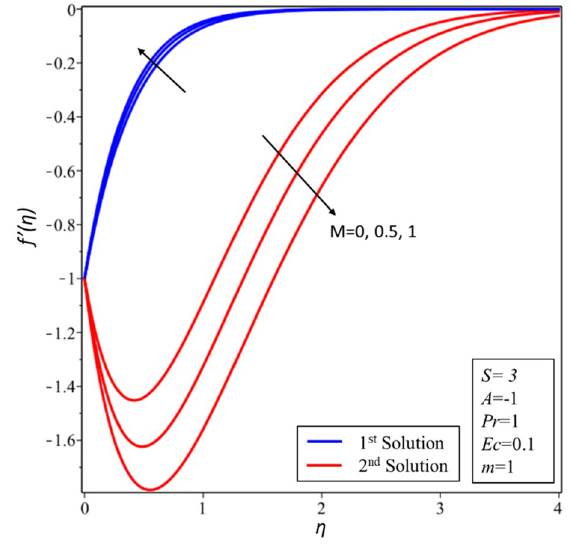
Figure 2. f ′(η) for increasing values of M and α = 1.